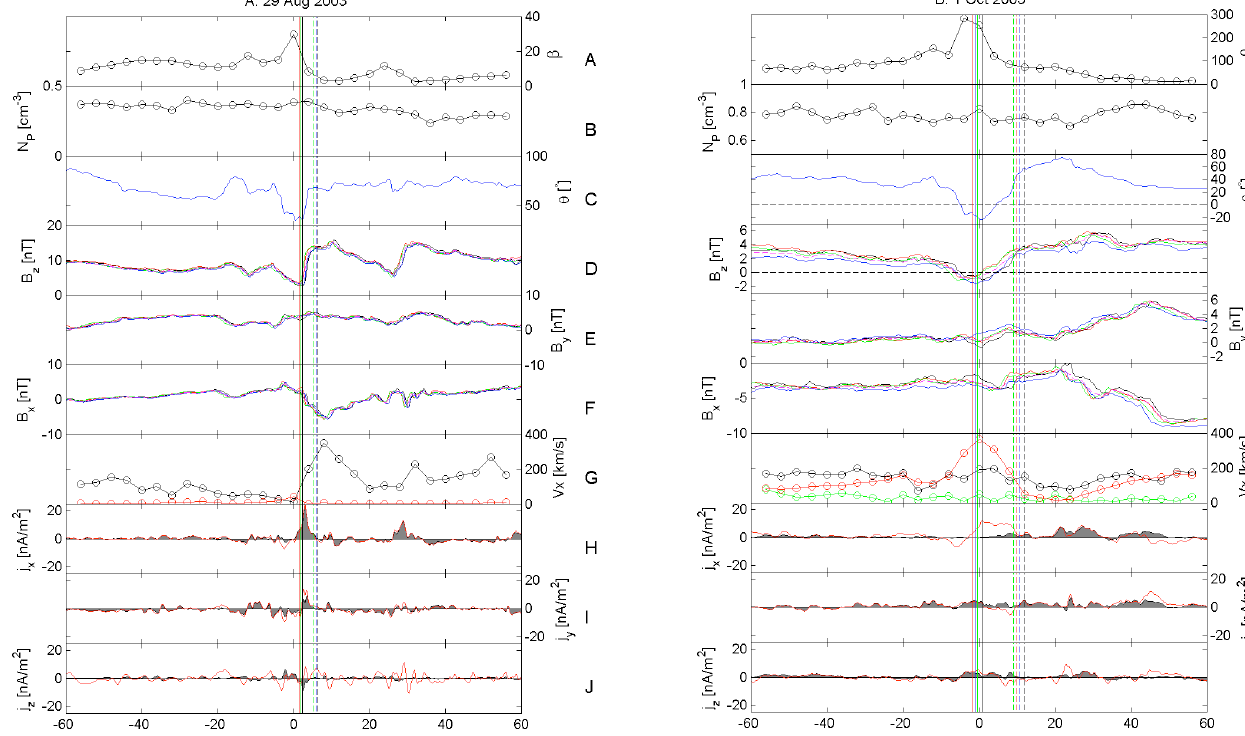
Fig. 2. Data for 29 August 2003 from 13:52UT till 13:54UT (left panel) and for 1 October 2003 from 20:59UT till 21:01UT (right panel). Panel (A) the proton density; Panel (B) the plasma- β ; Panel (C) the magnetic field inclination angle for C1; Panels (D) – (F) the three magnetic field components for all Cluster spacecraft; Panel G: The perpendicular plasma flow velocity V x (black), V y (red) and V z (green); Panels (H) – (J) the three components of the electric currents determined by the curlometer technique with the current perpendicular to the magnetic field shown as the filled region under the red curves. The two specific times for the ’timing-method’ (marked by the horizontal colored solid lines for B z , min and the dashed lines for B z , max are also